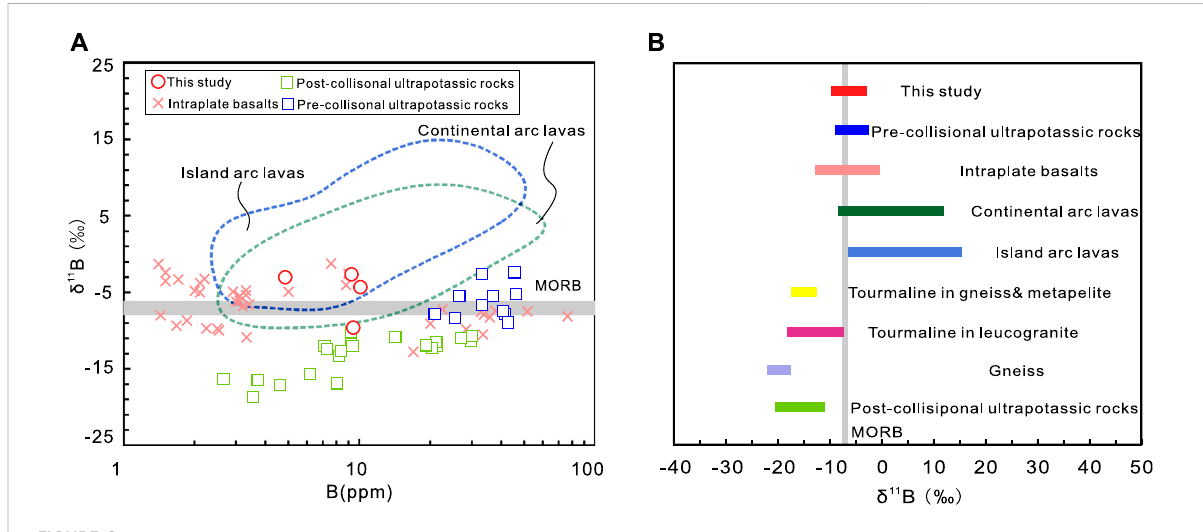
FIGURE 6 (A) Whole-rock δ 11 Bvs.BconcentrationsforSailiputrachyandesites. (B) BisotopesforSailiputrachyandesitesandmajorreservoirs.Datasource: intraplatebasalts(Tonarinietal.,2004;Tonarinietal.,2005;Lietal.,2016;Zhangetal.,2019);arclavas(islandandcontinentalarclavas;DeHoogand Savov, 2017); tourmaline in gneiss and metapelite, leucogranites (Hu et al., 2018); schist and gneiss (Fan et al., 2021); pre-collisional and post- collisional ultrapotassic rocks in the Lhasa block (Hao et al., 2022). The gray fi elds for δ 11 B of the MORBs are from Marschall et al.